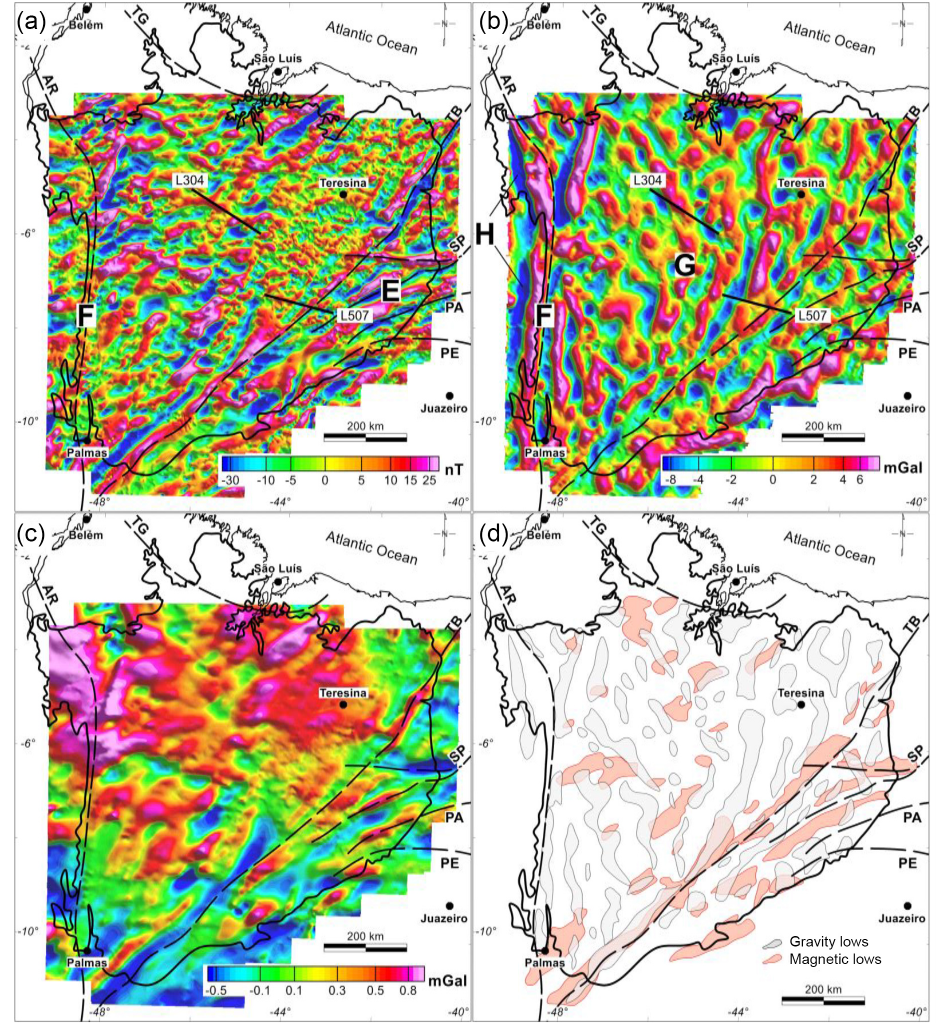
Figure 5. Residual reduced-to-pole magnetic (a) , gravity (b) and pseudo-gravity (c) anomaly maps of the Parnaíba basin. Main pseudo- gravity and gravity lows are highlighted in (d) . Brasiliano shear zones: AR – Araguaia; PA – Patos; PE – Pernambuco; SP – Senador Pompeu; TB – Transbrasiliano; TG – Tentugal. Labeled anomalies are discussed in the text. Magnetic and gravity anomalies along seismic lines L304 and L507 are shown in Fig.